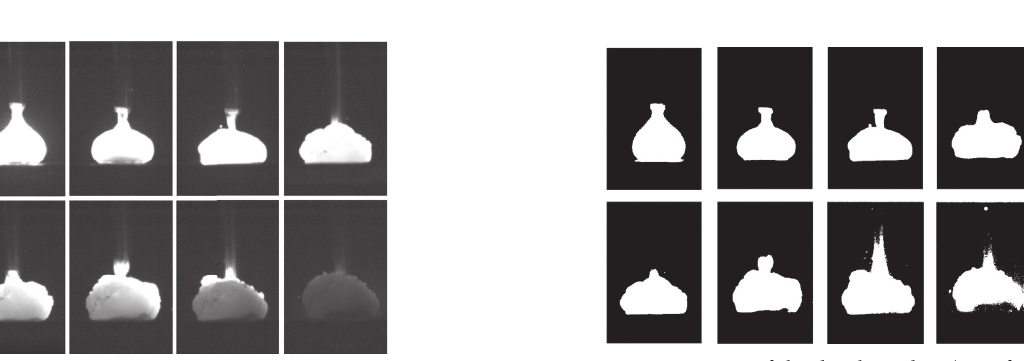
Figure 11: Arc shape and droplet transfer at different process levels: (a) wire feed speed is 3.0m/min; (b) wire feed speed is 5.0m/min.